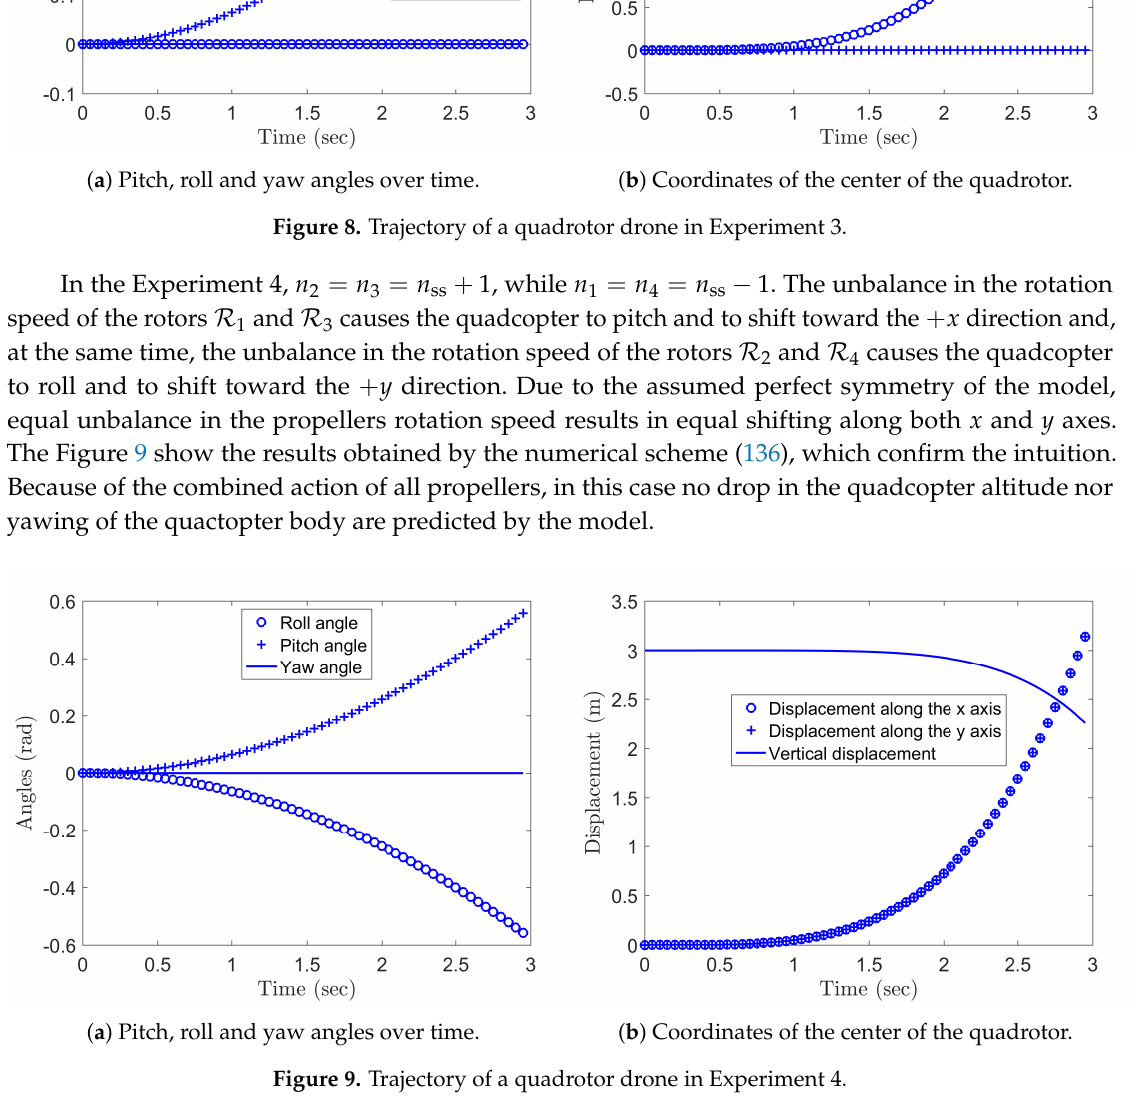
Figure 9. Trajectory of a quadrotor drone in Experiment